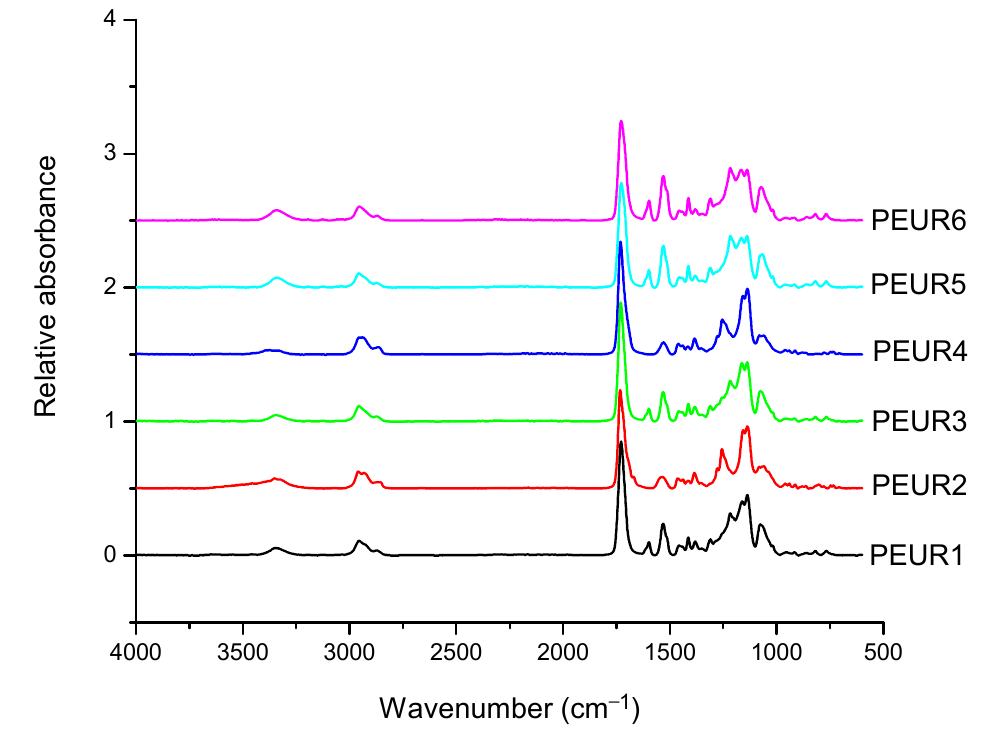
Figure 1. FTIR spectra of the initial PEURs.